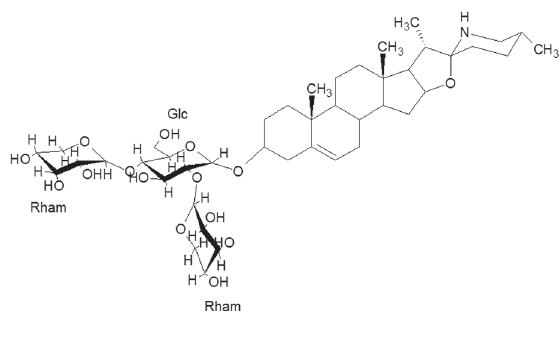
Figure 1 - Chemical structures of